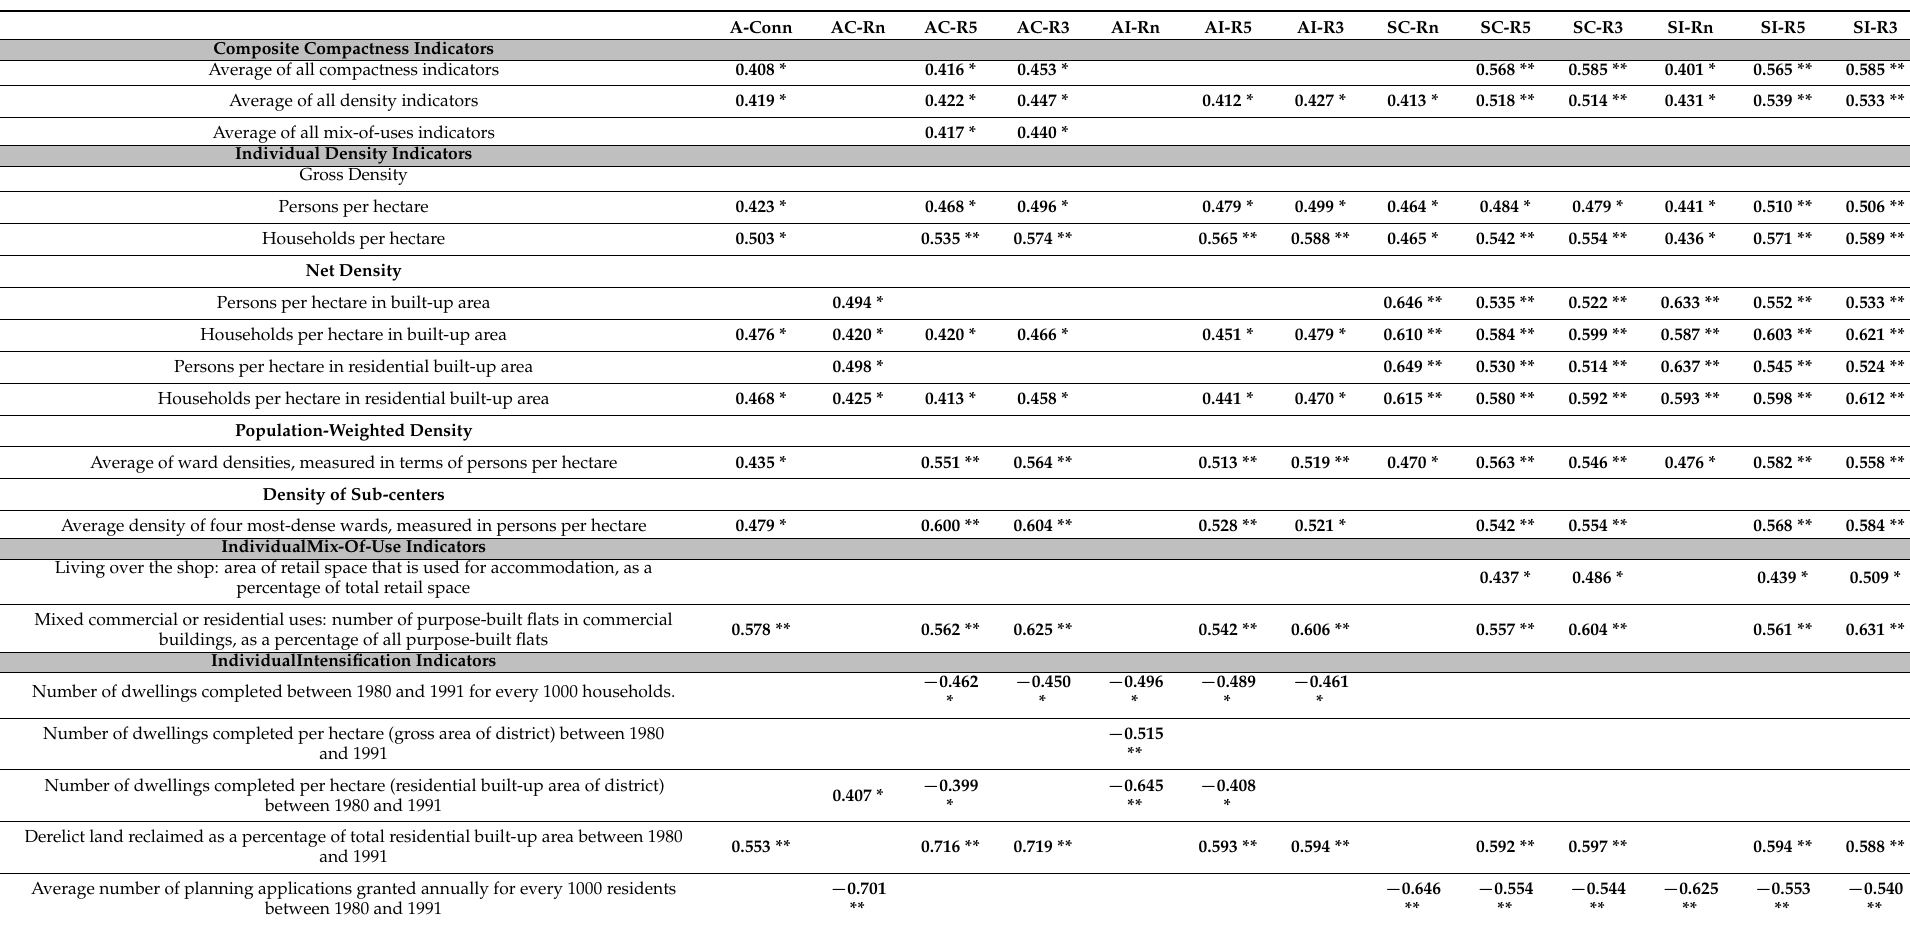
Table 2. The table shows only the significant correlations between street network measures and composite compactness indicators, and those between street network measures and individual density, mix-of-use, and intensification